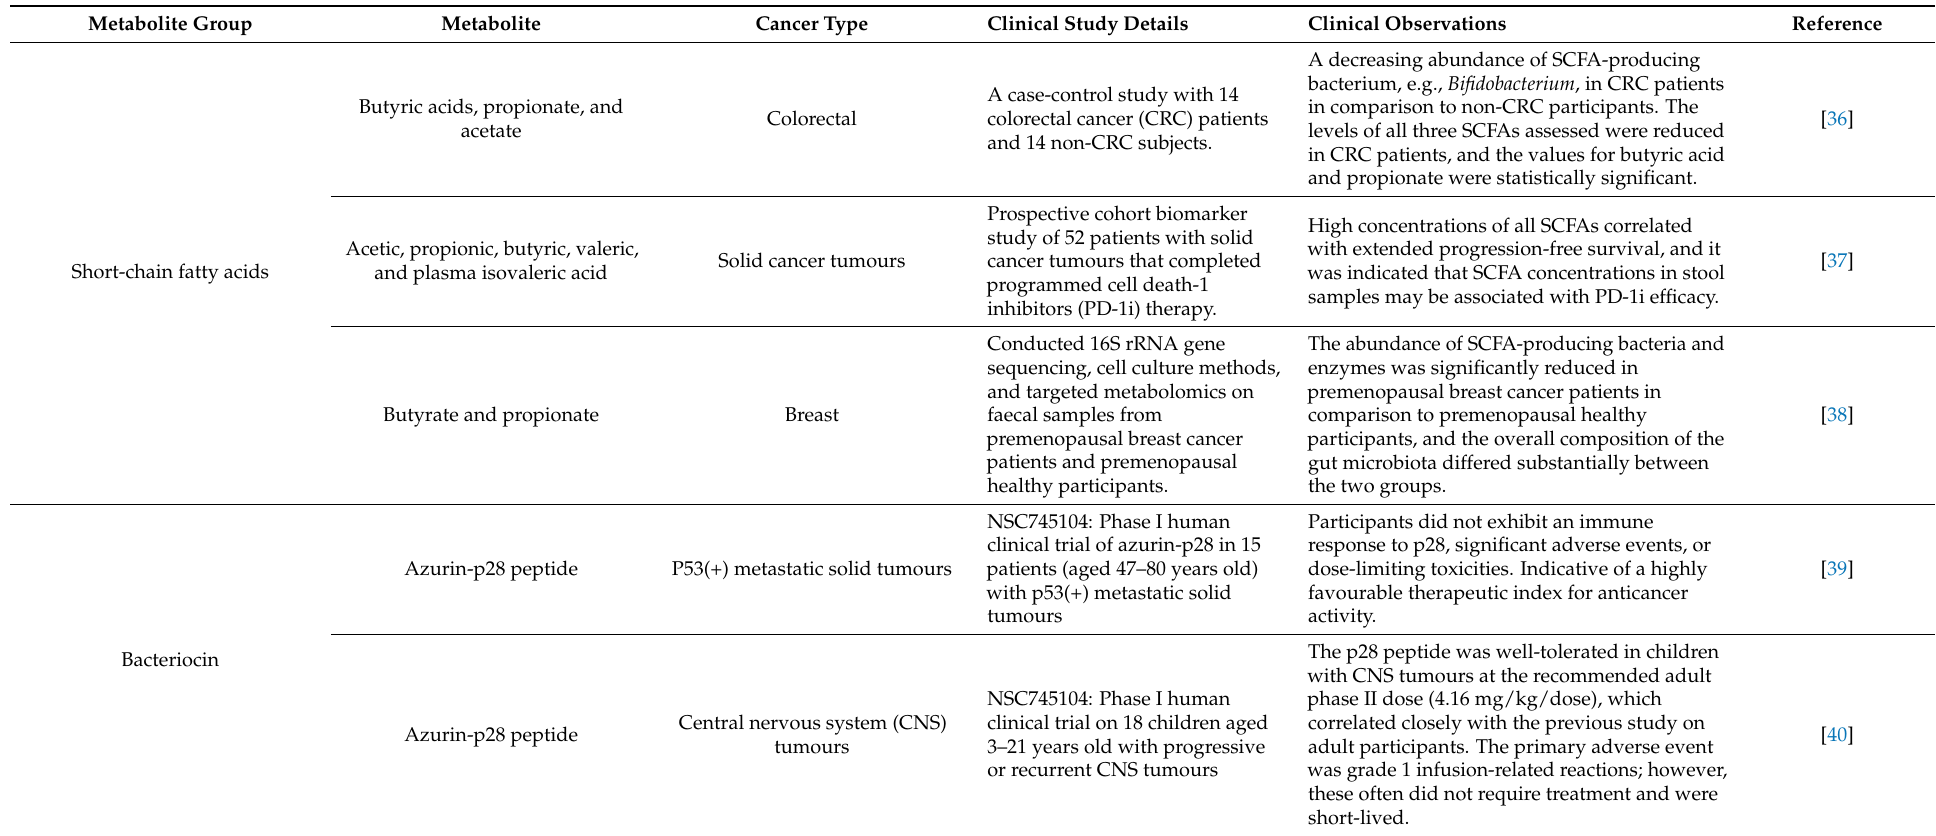
Table 2. A tabulated summary of the clinical research on key gut metabolites for their action against different malignancies including breast